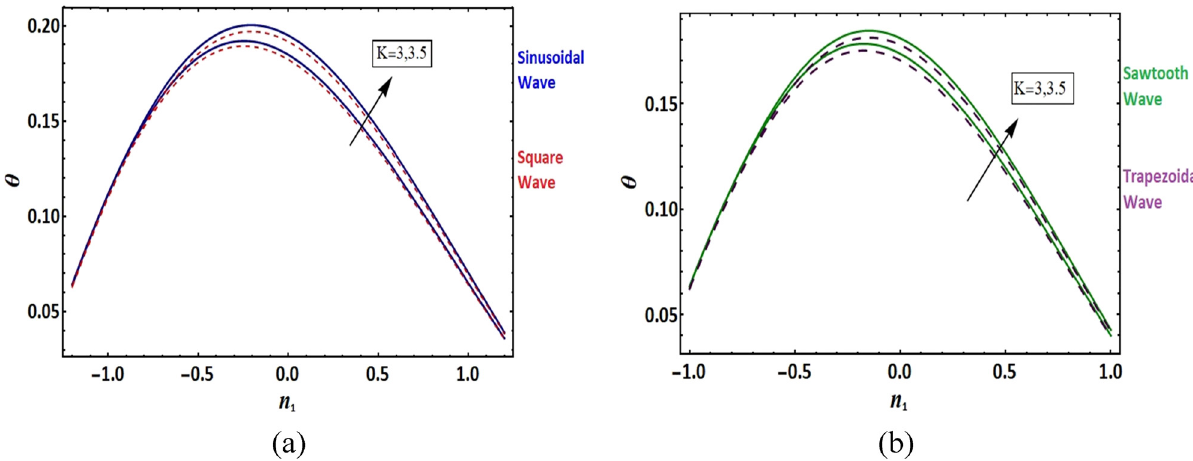
= 0.1, A = 2, A = 1, M = 0.2,Sr = 0.5, K 1 3 1